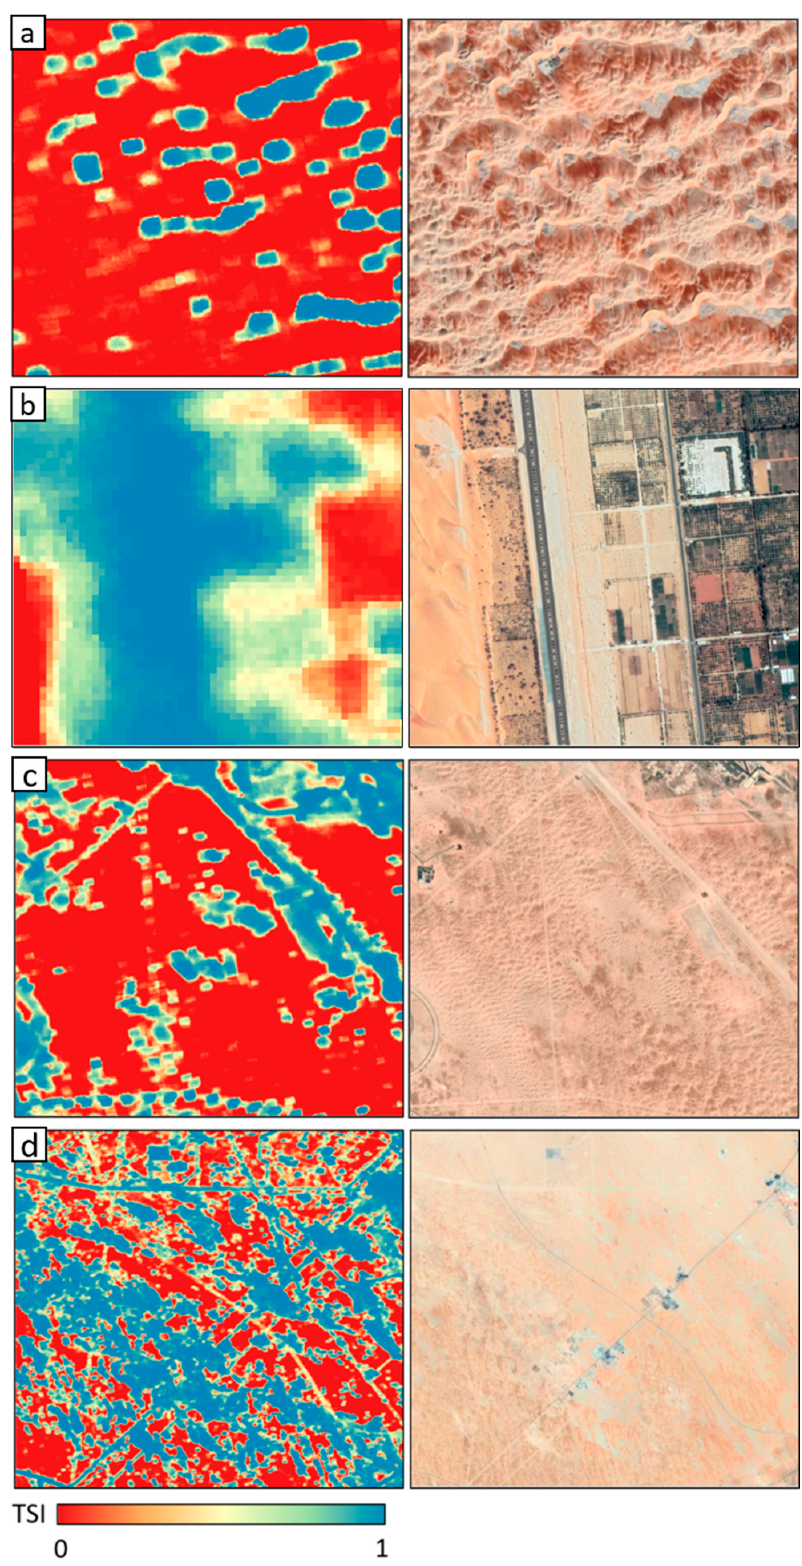
Figure 6. Temporal Stability Index (TSI) and high-resolution satellite optical image for the sub-areas highlighted in Figure 5. Basemap: © Google 2019 Copyright.